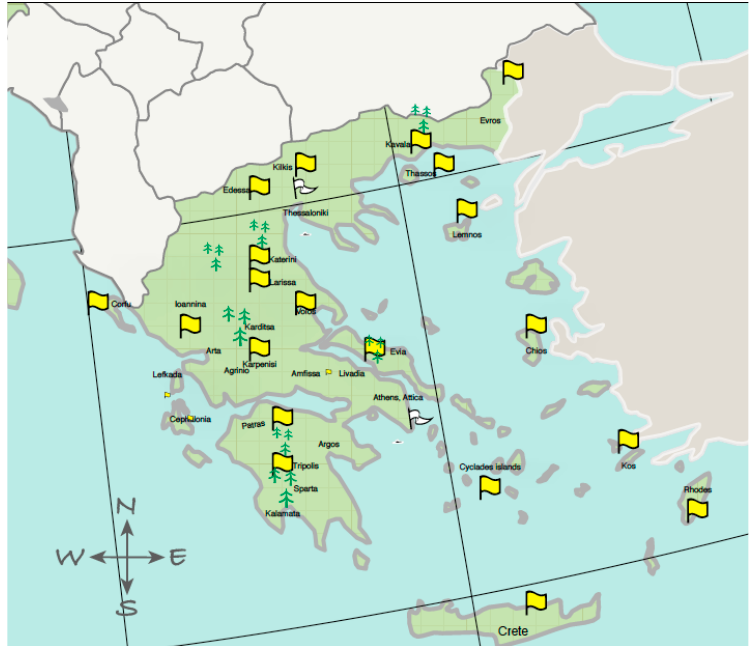
Figure 1. Sample collection points., created by Ortelius software Version